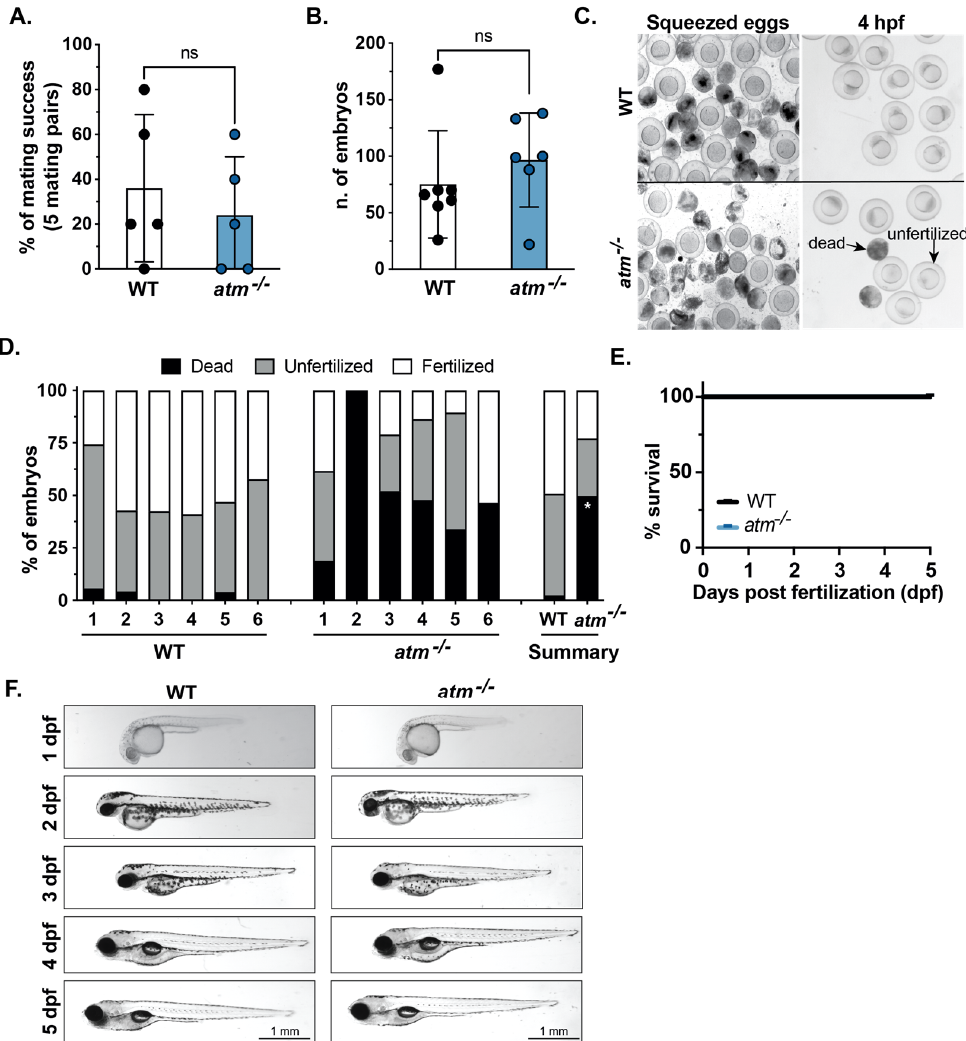
Figure 3. atm mutation is well tolerated in zebrafish embryos. ( A ) The percentage of mating success calculated from 5 individual pairs over 6 independent matings for WT and atm − / − mutants. Each dot indicates the average success of each mating pair based on the production of any embryos. ( B ) The number of embryos generated for paired mating of WT and atm − / − adults. Each dot indicated a different mating. ( C ) Images of WT and atm − / − mutants after squeezing and at 4 h post-fertilization (hpf) showing fertilized, unfertilized and dead embryos. ( D ) Stack bar indicates dead, fertilized, and unfertilized as categorized in panel C for individual mating pairs of WT and atm − / − mutants. Summary stack bars show the average of each phenotype for WT and atm − / − mutants. ( E ) Survival curve of WT and atm − / − mutants from 1 to 5 dpf indicates no signi fi cant di ff erences between fertilized embryos of WT and atm − / − mutants. ( F ) Representative images of live WT and atm − / − mutants from 1 to 5 dpf show no observable morphological di ff erences are detected. Values are expressed as the mean ± SD and were compared by unpaired t-test. Signi fi cant di ff erences are indicated as follows: ns p > 0.05 (non-signi fi cant), * p < 0.05.